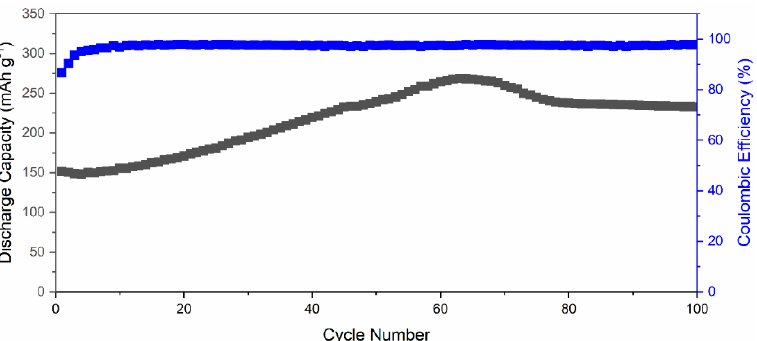
Figure 7. Long-term cycling performance of a Li-ion battery featuring δ -CsPbI 3 as active materials, tested at 0.1C-rate.